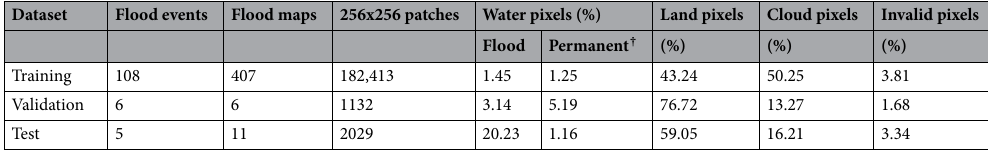
Table 1. General statistics of the training, validation and test splits of the WorldFloods dataset. Since raw images from S2 can be many megapixels in size, we tile each image into 256-pixel square patches. The training set distribution has a higher percentage of cloudy pixels compared with the validation and test datasets; this is because we were interested in distinguishing water/flood pixels whereas detecting clouds is a byproduct of the model. † Permanent water obtained from the yearly water classification product of Pekel et al. 44 available at the Google Earth Engine 52